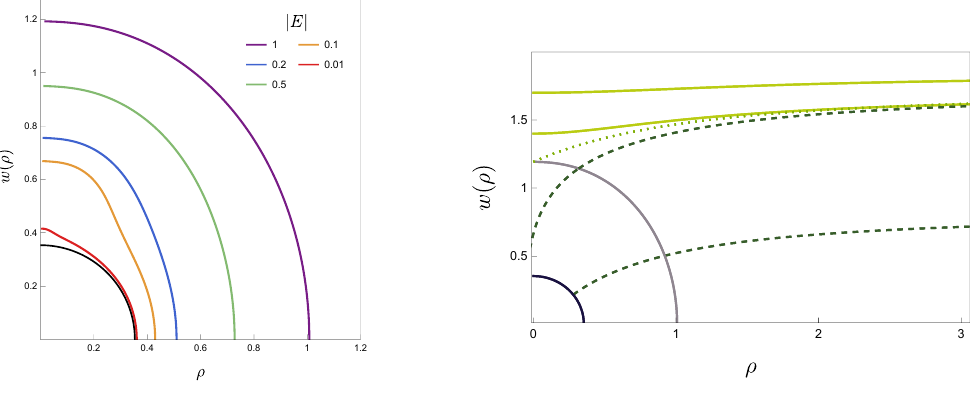
Figure 1 . Left plot : shapes of the singular shells as a function of the applied electric field. The p axes are ρ = u 1 − ψ 2 and w = u ψ with ψ = sin θ . The curves are the points ρ 2 + w 2 = u c ( E, ψ 0 ) with ψ 0 = sin θ 0 the embedding angle at the singular shell. Outside the limit E → 0 the shell shape is non spherical. Hence, unlike the case of a constant electric field, in the rotating situation we have a non trivial dependence of u c on the mass m of the D5-brane at fixed | E | . Right plot : profiles of different embeddings for Ω = | E | = 1 . The dashed lines represent black hole embeddings. They can be either regular (thermal), ending on the horizon, or singular, ending in a conical singularity. The dotted line represents a critical embedding. The solid lines represent Minkowski embeddings. The black hole and pseudo-horizon are shown by the black (inner) and gray (outer)